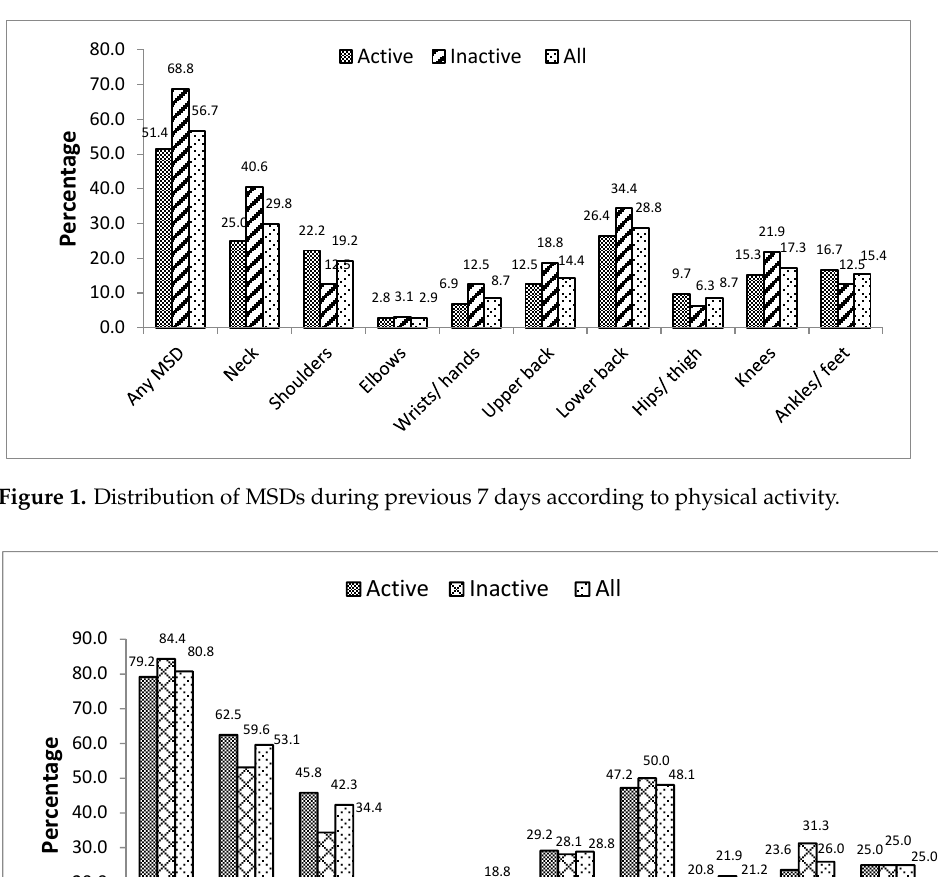
Table 3. Association of MSDs during the previous 7 days and the previous 12 months with physical activity practice.